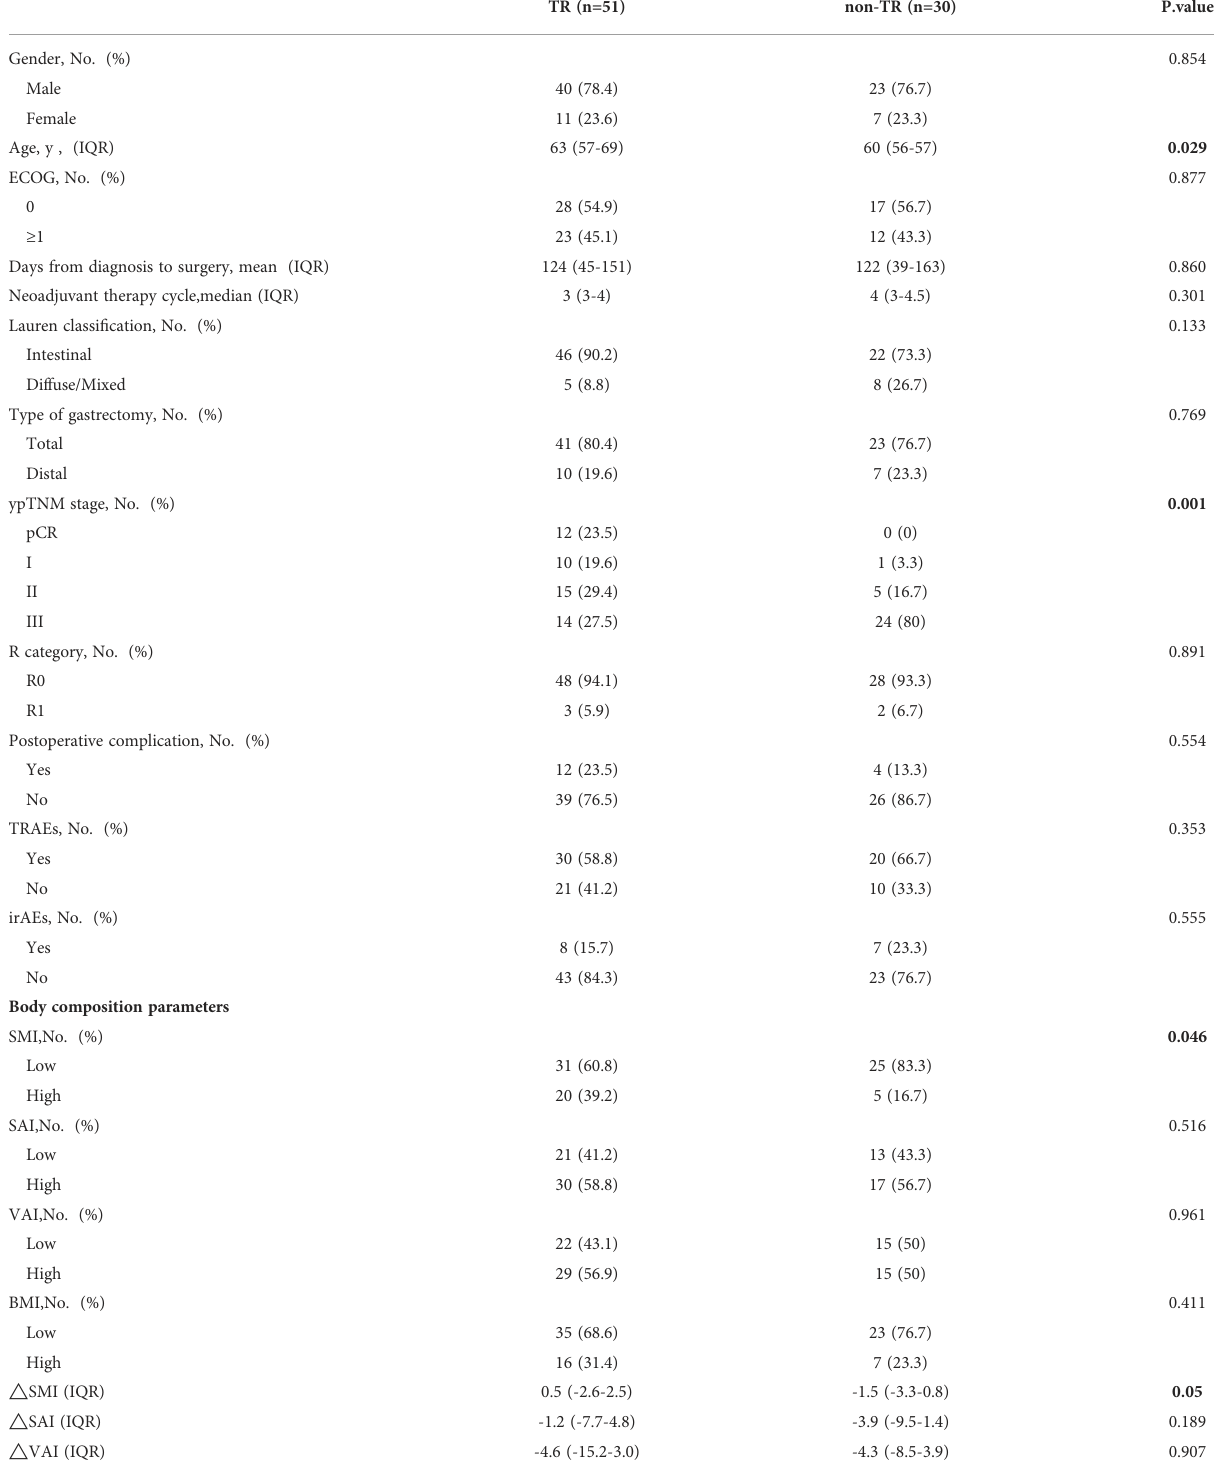
TABLE 3 Comparison between two groups of general data and body composition. TR (n=51) non-TR (n=30)